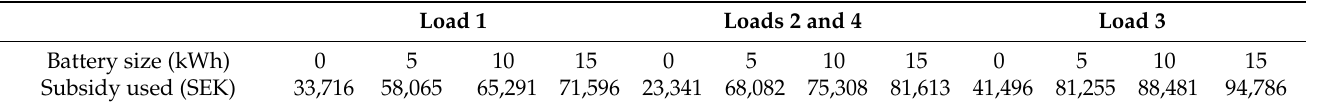
Table 2. Subsidies used in the cost